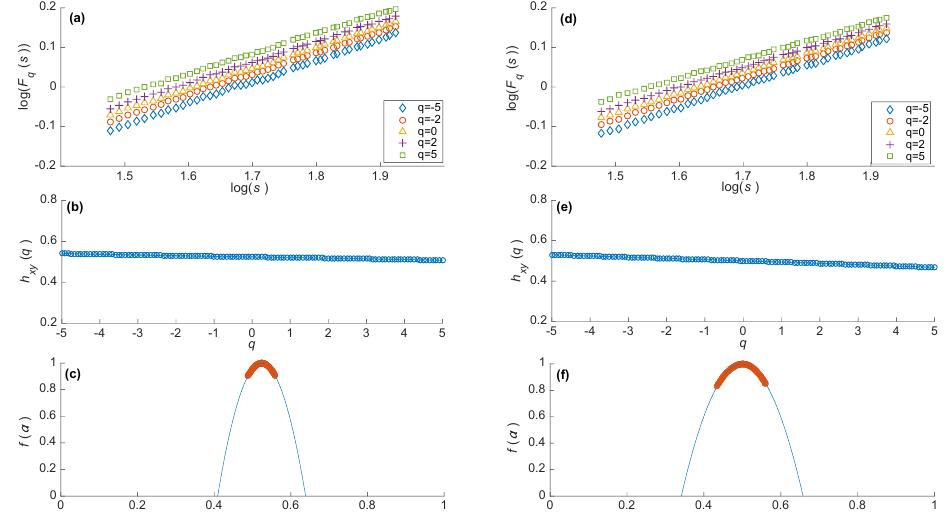
Figure 4. Multifractal Detrended Fluctuation Analysis (MF-DFA) results for the shuffled series of global CH 4 ; ( a ) Plot of log( F q ( s )) against log( s ); ( b ) Plot of h xy ( q ) against q ; ( c ) Multifractal spectrum f ( a ) against a .